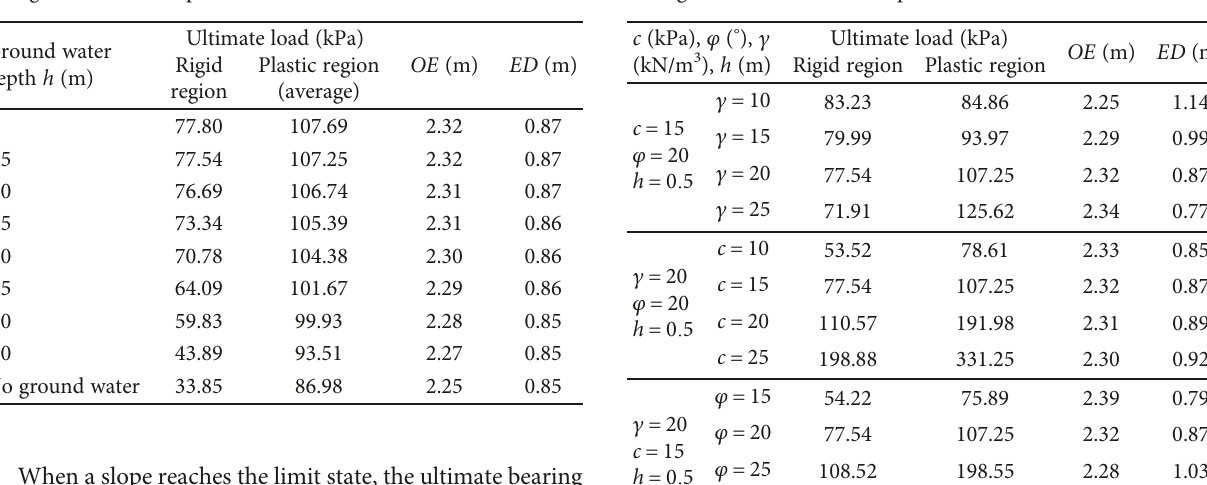
Figure 12: Velocity fi eld of the slope under the limit state. Table 1: Variation of the ultimate loads and the distribution of the Table 2: Variation of the ultimate loads and the distribution of the sliding belt with the depth h . sliding belt with di ff erent soil